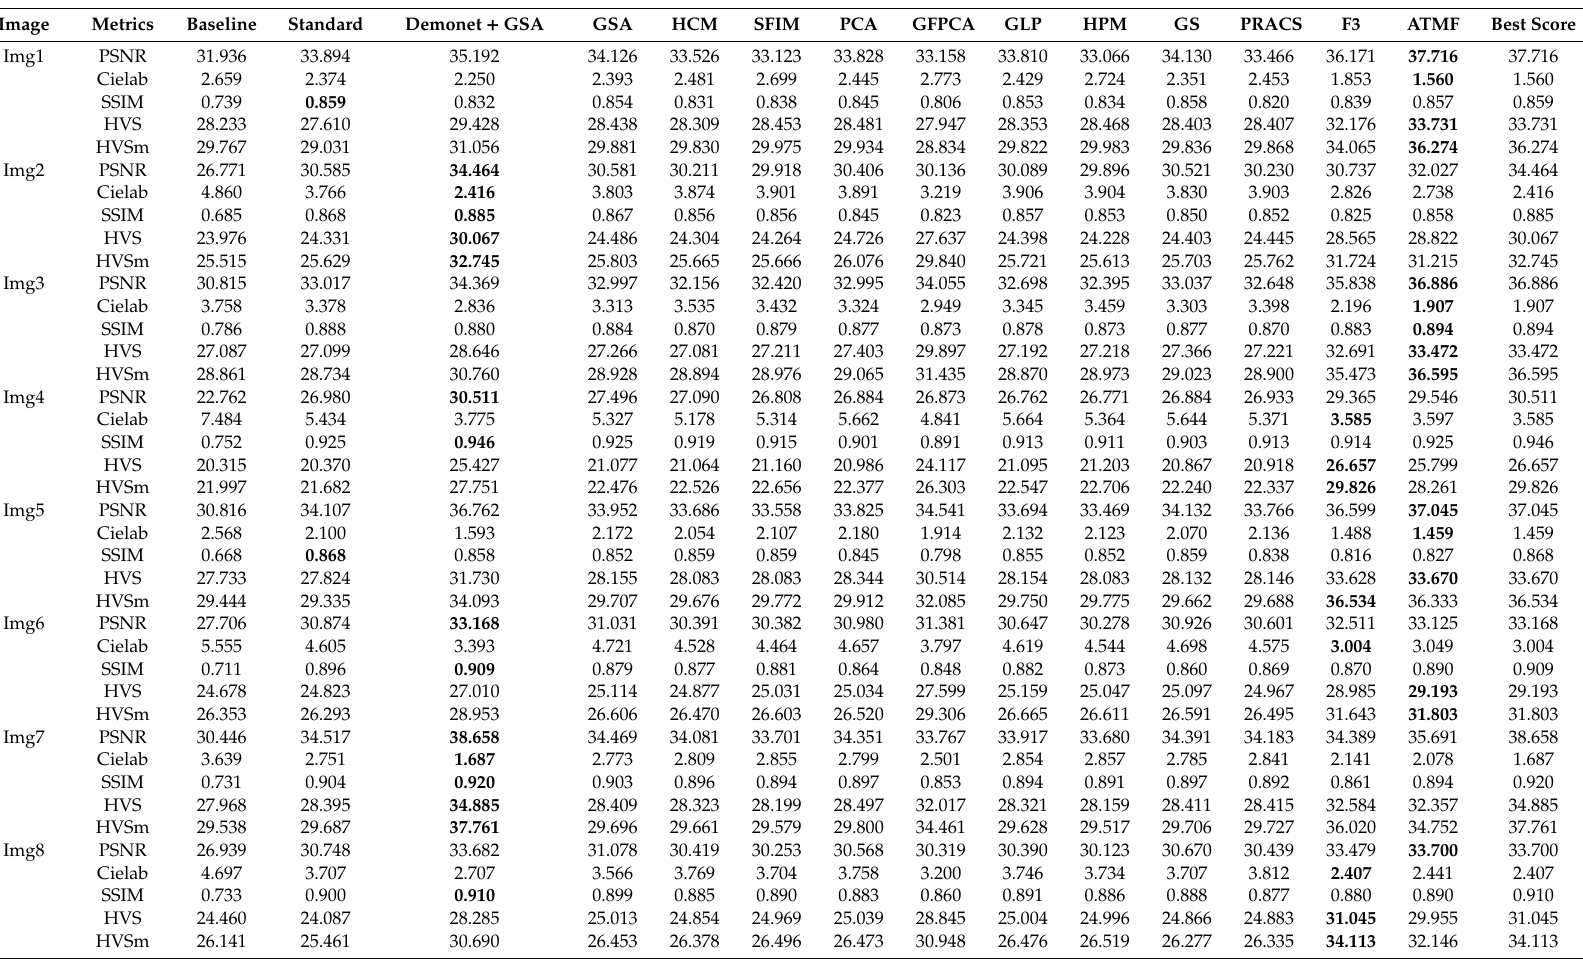
Table A2. Performance metrics of 14 algorithms for clean images. Bold numbers indicate the best performing method in each row. Red numbers indicate those methods used in F3 and those red and green numbers indicate those methods used in ATMF. Bold numbers indicate the best performing methods in each row. Image